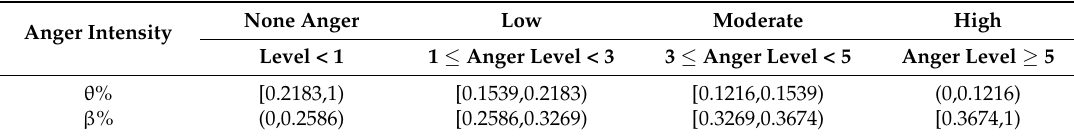
Table 4. The optimal threshold (best cut-off points) for discriminating different anger intensity.